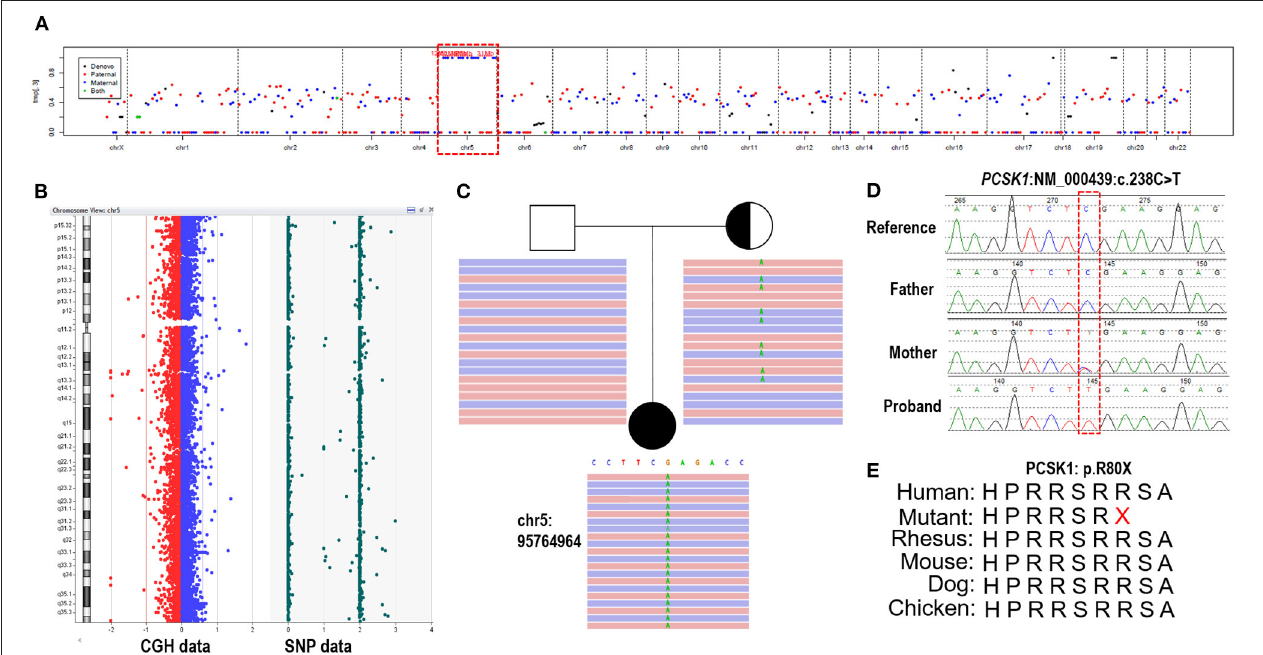
FIGURE 2 | The genetic test results of the patient. (A) Trio-ES identified homozygous variants on chromosome 5 and inherited from her mother, suggesting that the proband has UPD(5)mat. (B) Array-CGH confirmed UPD(5) by showing the copy neutral AOH across the whole chromosome 5. (C) A homozygous nonsense variant on PCSK1 (c.238C > T) is detected in the proband. Her mother is heterozygous and her father is normal. (D) The variant is confirmed by Sanger sequencing. (E) The variant site is conserved in different species.